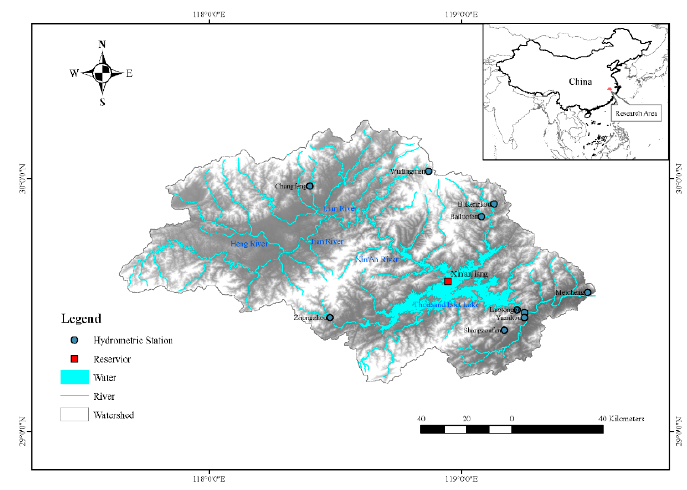
Figure 3. Location of the Xinanjiang Reservoir.